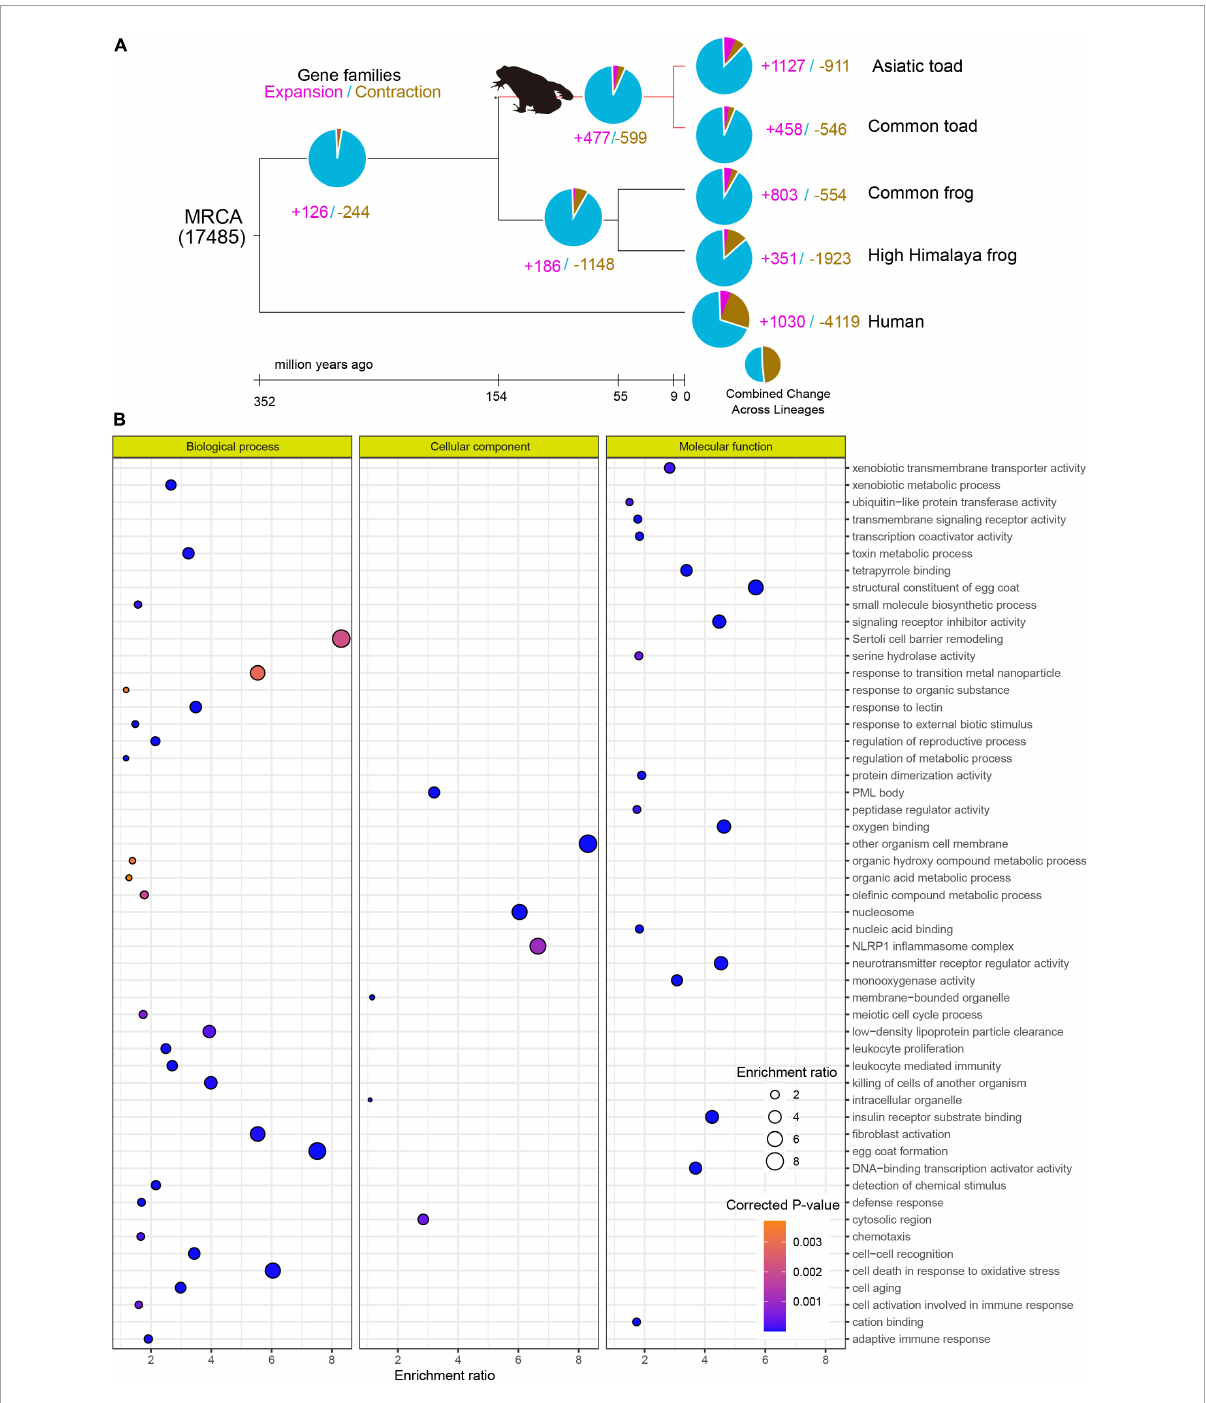
FIGURE3 Gene-family dynamic analysis and functional enrichment of toad expanded genes in Asiatic toad. (A) Gene-family expansion and contraction among Asiatic toad, common toad, common frog, high Himalaya frog, and human. (B) Gene Ontology (GO) enrichment of the toad expanded genes. Enrichment ratio and corrected p value are the same as those in Figure 2